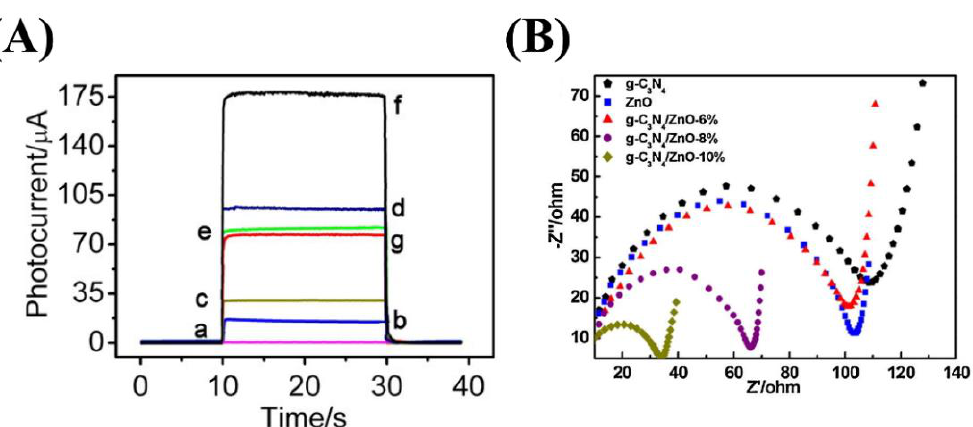
(MCH) (“trace e”). For comparison, the photocurrent of CdSe QDs with or without the bio-functionalization of DNA 2 on the electrode matrix is 180 and 78 μA, respectively [557]. Figure 21. ( A ) Photocurrent responses of (a) FTO, (b) FTO/TiO 2 , (c) FTO/TiO 2 /g-C 3 N 4 , (d) FTO/TiO 2 / g-C 3 N 4 /CdS, (e) FTO/TiO 2 /g-C 3 N 4 /CdS/capture-DNA 3 /MCH, (f), FTO/TiO 2 /g-C 3 N 4 /CdS/capture- DNA 3 /MCH/DNA 2 -CdSe, (g) FTO/TiO 2 /g-C 3 N 4 /CdS/capture-DNA 3 /MCH/CdSe, Copyright © 2022 American Chemical Society [557]; ( B ) Nyquist plots of ZnO, g-C 3 N 4 /ZnO composites and g-C 3 N 4 nanosheets electrodes, Copyright © 2022 American Chemical Society [559].